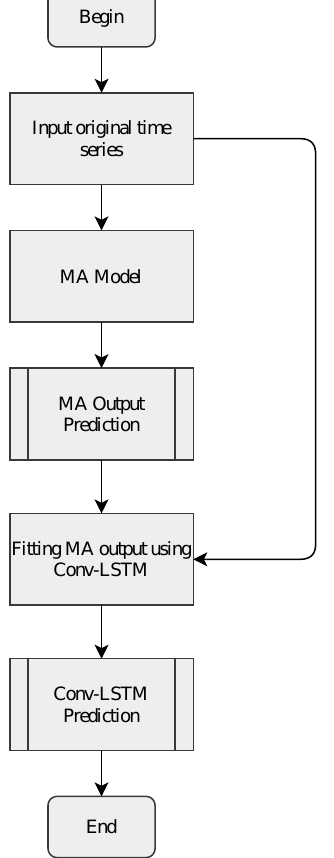
Figure 3. hLSTM-Aging prediction